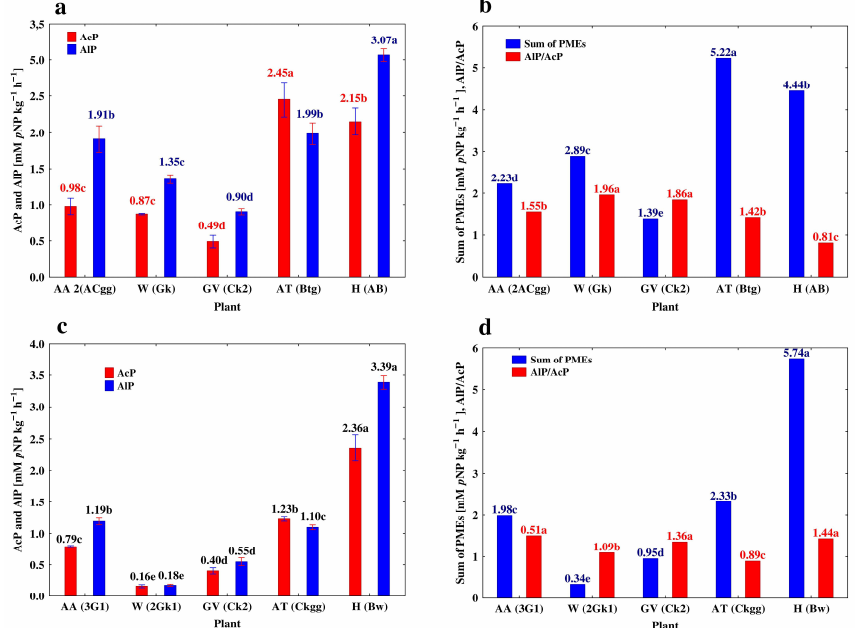
Figure 2. Effect of cultivated plants on the activity of acid and alkaline phosphatase (AcP, AlP) and sum of PMEs activities as well as the AcP/AlP ratio in third horizons (ACgg, Gk, Ck2, Btg, AB) ( a , b ), respectively) and in the fourth horizons (3G1, 2Gk1, Ck2, Ckgg, Bw) ( c , d ), respectively). AA—alfalfa, W—winter wheat, GV—grapevine, AT—apple trees, H—hop. PMEs—the sum of phosphomonoesterases (AcP and AlP). Values for each property marked by different small letters are statistically different at p < 0.05. Abbreviations of soil horizon names are explained under Table 1.